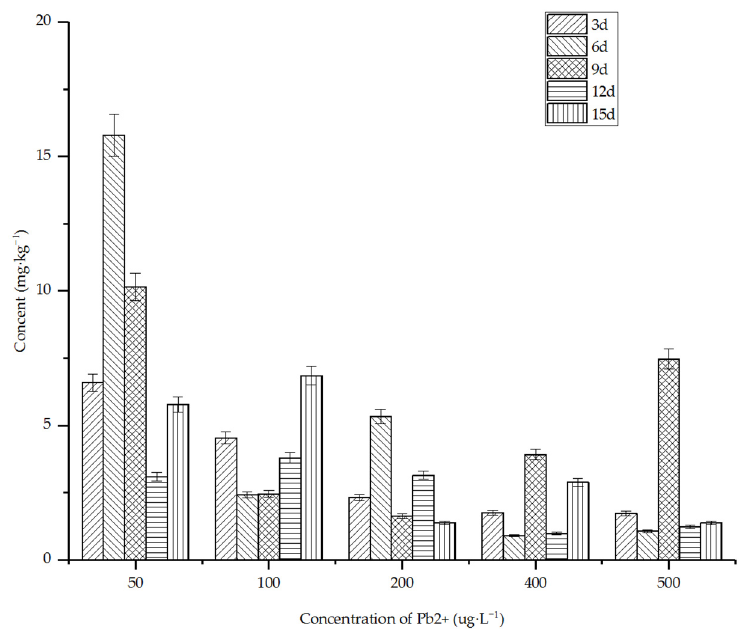
Figure 7. Absorption of heavy metal lead ions by Suaeda salsa.